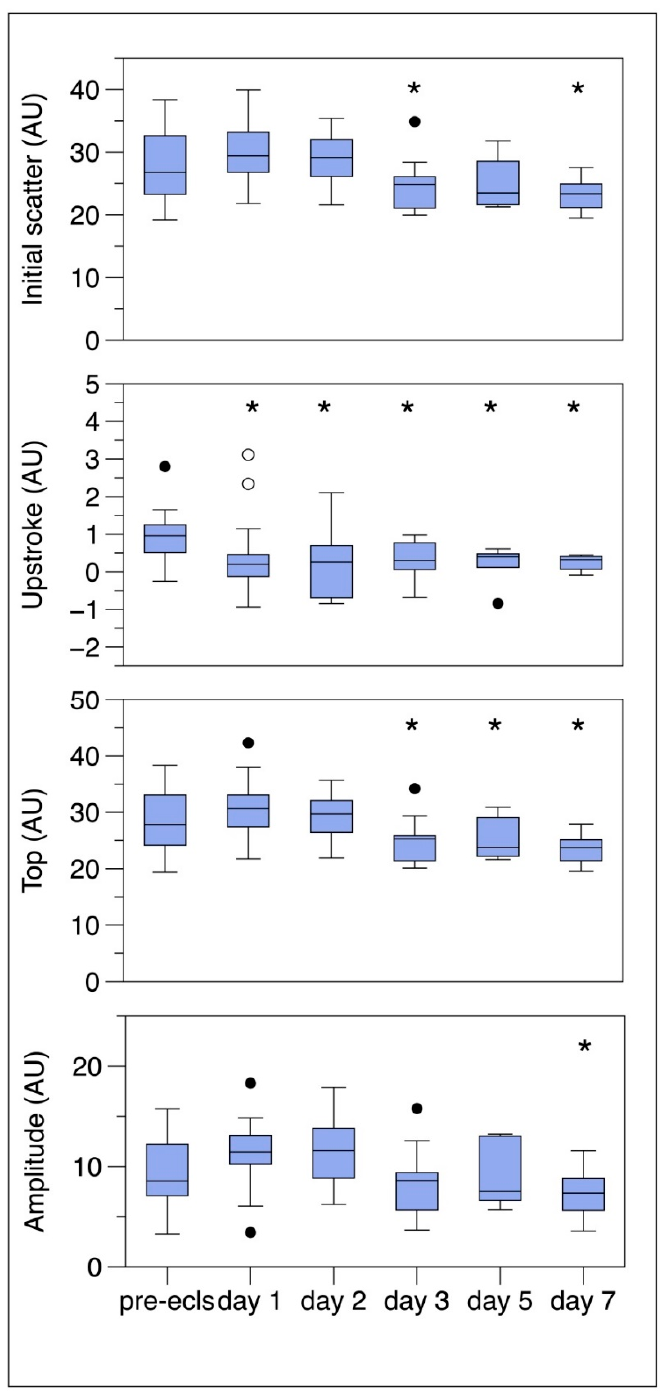
Figure 3. Changes over time in the components that form the syllectogram with the laser-assisted optical rotational red cell analyzer. The initial scatter reflects the complete disaggregation of the RBCs at a preset shear stress. The upstroke reflects that the RBCs resume their normal biconcave shape. This culminates in the top from which the aggregation process starts. The complete aggregation is reflected in the amplitude. Boxes represent the interquartile range (25%–75%), dots represent the outliers. * p = 0.05 indicating significant difference with pre ECLS value. AU = Arbitrary Units. ECLS = extracorporeal life support.